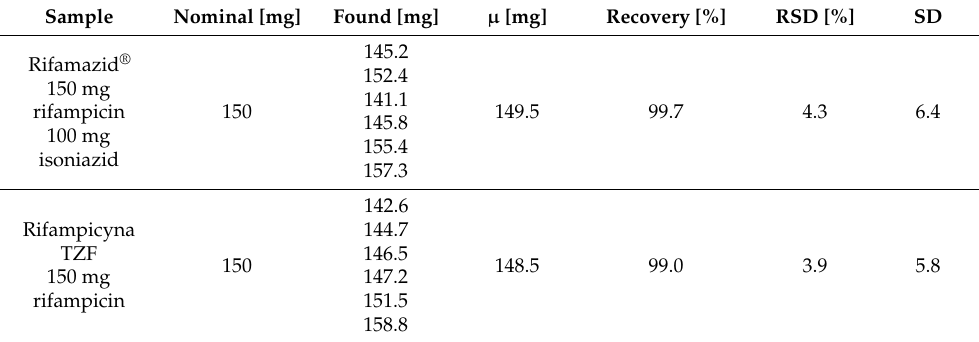
Table 3. Rifampicin determination in pharmaceuticals